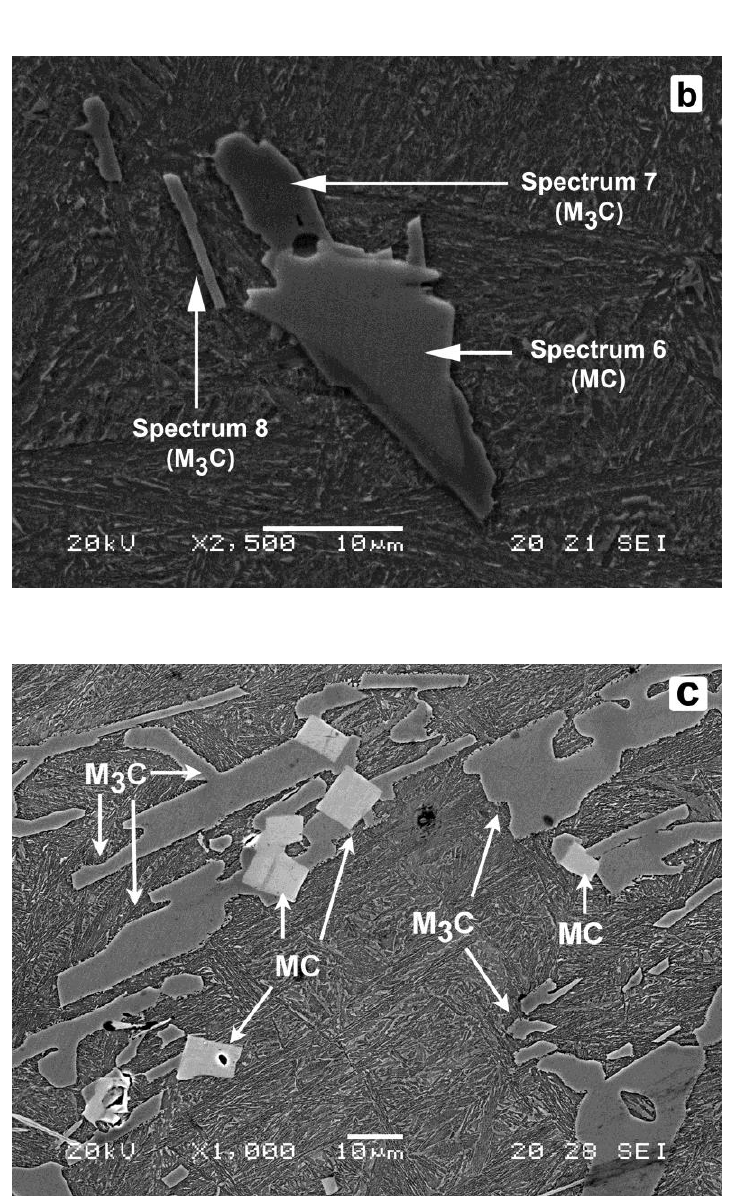
Figure 2. Microstructure obtained under scanning electron microscopy in which the different types of carbides can be distinguished: ( a ) Experiment 8, Region I of the working layer, EDX analysis; ( b ) Experiment 5, Region II of the working layer, EDX analysis; and ( c ) Experiment 8, Region II of the working layer, carbides of MC (NbC) and M 3 C (cementite-like carbides) stoichiometry.